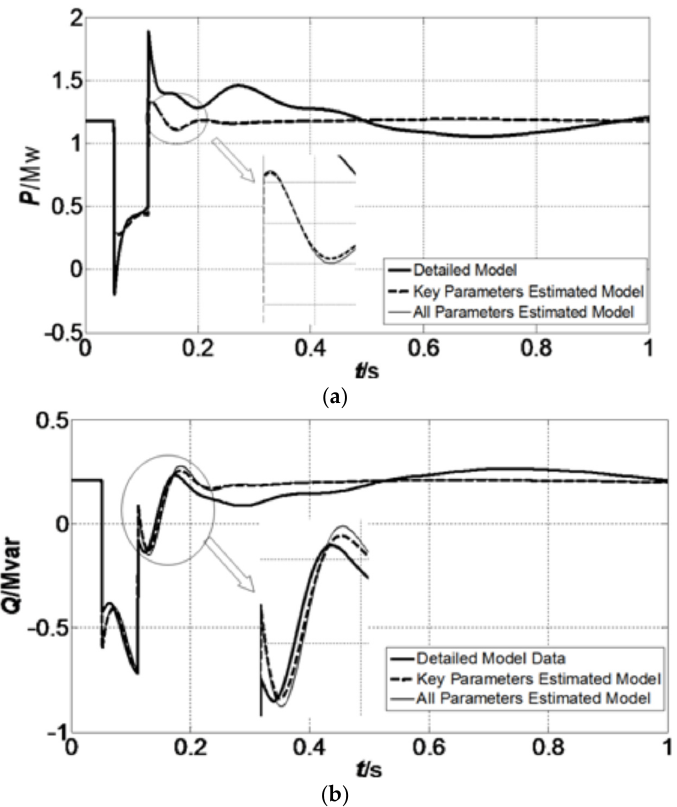
Figure 8. ( a ) The active power dynamics of microgrid. ( b ) The reactive power dynamics of